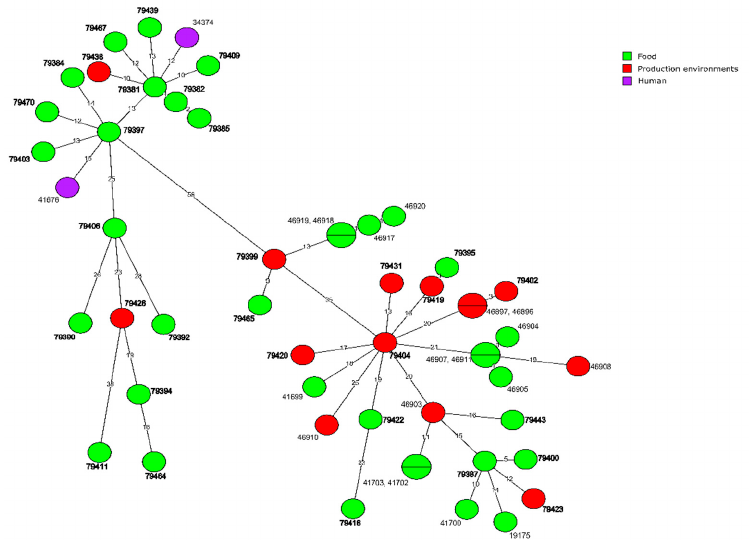
Figure 5. Minimum spanning tree (MST) based on the cgMLST profiles of L. monocytogenes CC121 tested in the present study with publicly available 20 strains of CC121 from Poland. Source of the isolates are represented by colored circles where the size is proportional to the number of strains. Numbers on the branches show alleles differences between neighboring nodes (CTs). The strain numbers in bold represent L. monocytogenes isolates from the present study.